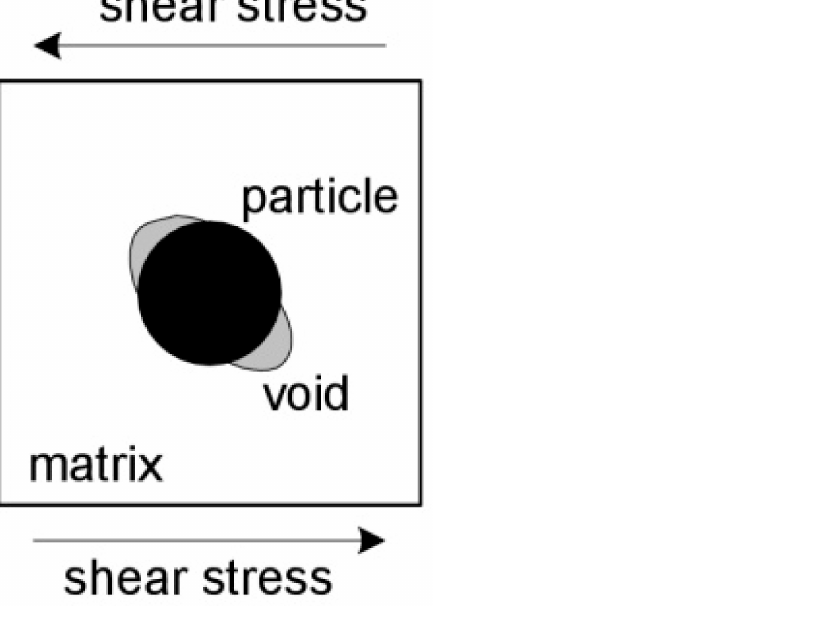
Figure 6. Mechanism of particle–matrix separation under dominant shear stress, based on